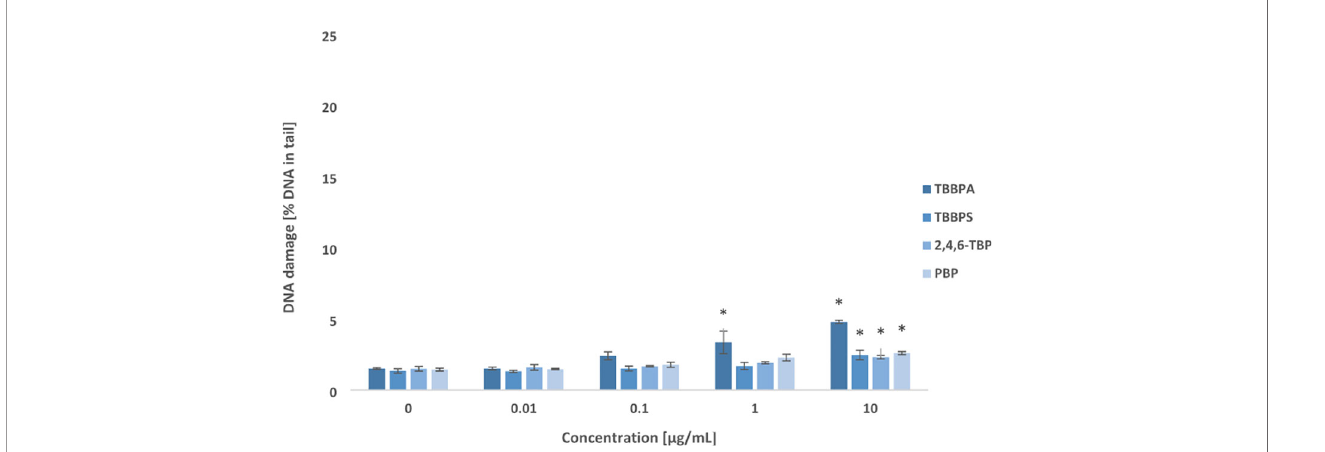
FIGURE 2 | Double DNA strand breaks formation. DSBs formation in human PBMCs treated with TBBPA, TBBPS, 2,4,6-TBP and PBP at the concentrations of 0.01 µg/mL, 0.1 µg/mL, 1 µg/mL and 10 µg/mL for 24 h. DNA damage was measured as the percentage of DNA in the comet tail using the neutral version of the comet assay. Mean ± SD was calculated from 3 individual experiments (3 blood donors). Statistically different from negative control at *P<0.05. Statistical analysis was conducted using one-way ANOVA and a posteriori Tukey